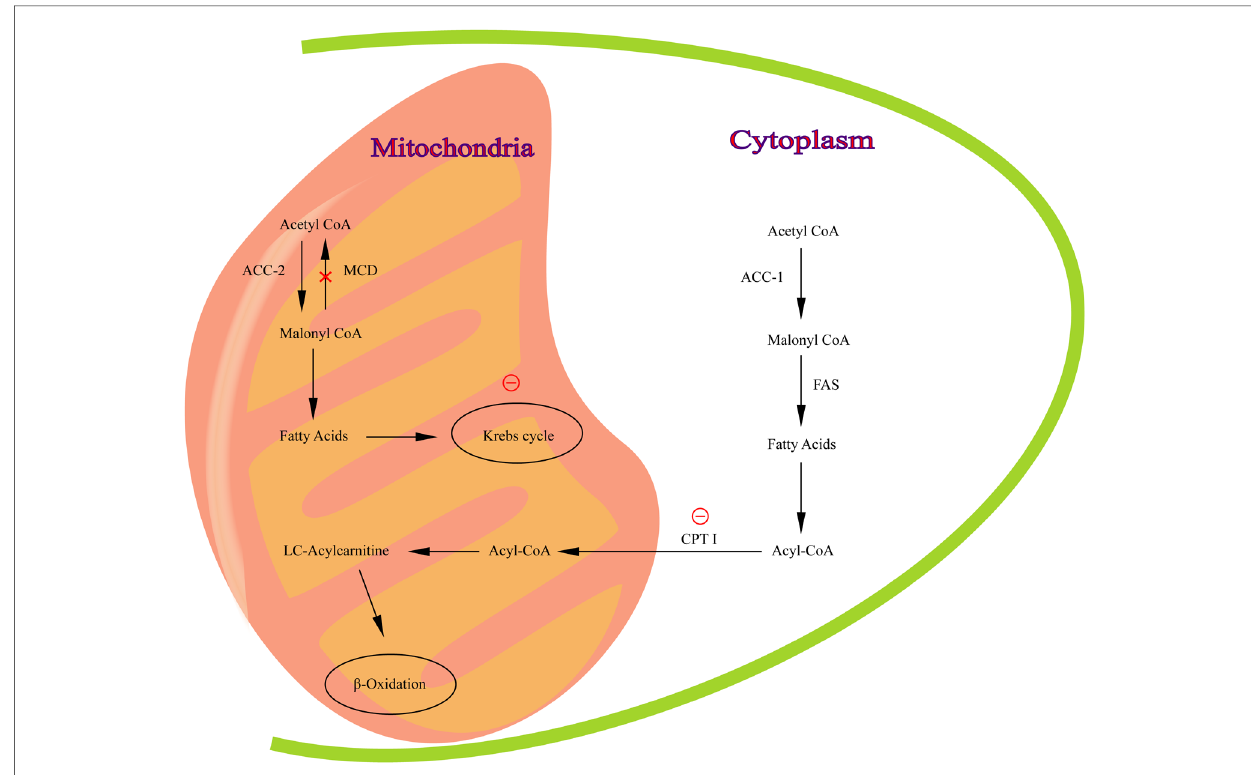
FIGURE 1 The pathway of malonyl-CoA regulation of fatty acid metabolism. MCD catalyzes the conversion of malonyl -CoA to acetyl-CoA in mitochondria. Red circle, inhibition of CPT I and Krebs cycle by